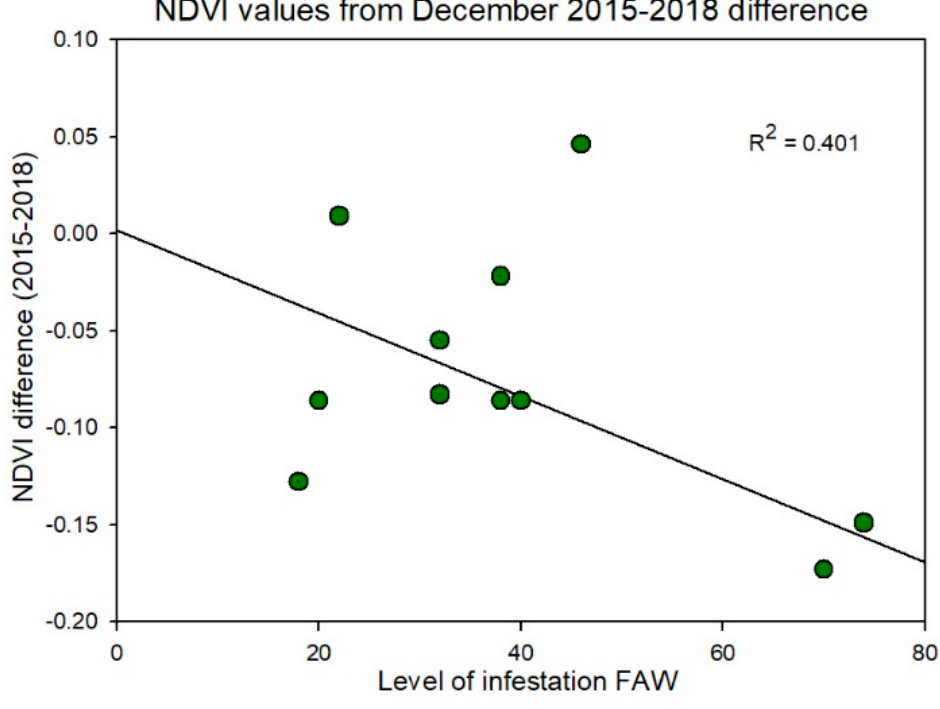
Figure 6. Difference between the NDVI average from December 2015 (farms without the FAW) and the NDVI average from December 2018 (farms with the FAW) against the level infestation of the FAW (0 to 100) in the maize field collected by the FAMEWS app.